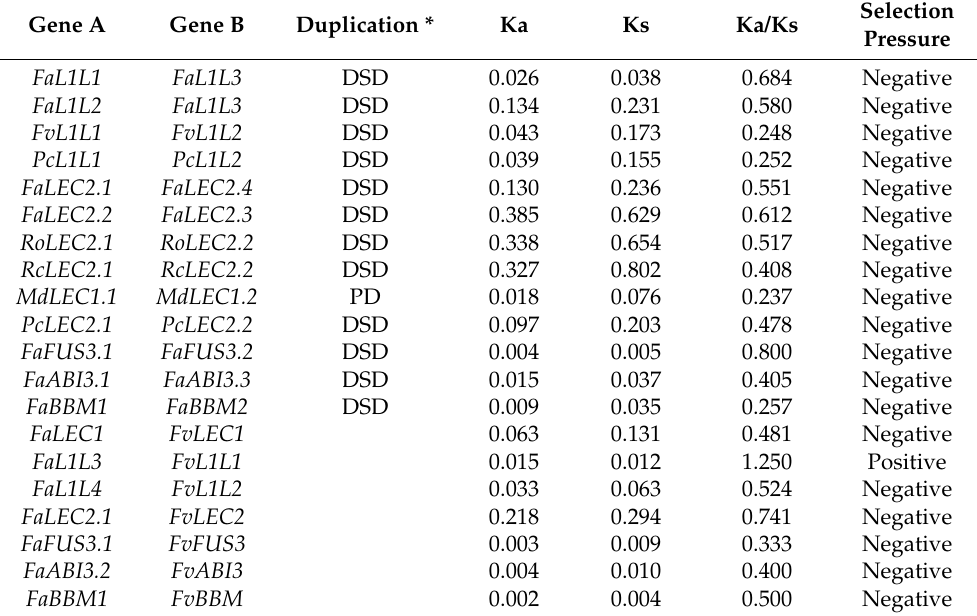
Table 3. Molecular evolutionary rates for LEC1 , L1L , LEC2 , FUS3 , ABI3, and BBM paralogous genes in Fragaria × ananassa and other species of the Rosaceae family. Gene A Gene B